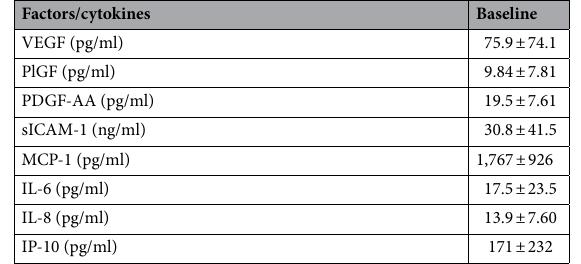
Table 2. Aqueous humor factors/cytokines at baseline. VEGF = vascular endothelial growth factor; PlGF = placental growth factor; PDGF = platelet-derived growth factor; MCP = monocyte chemotactic protein; sICAM = soluble. intercellular adhesion molecule; IL = interleukin; IP-10 = interferon-inducible 10-kDa protein.